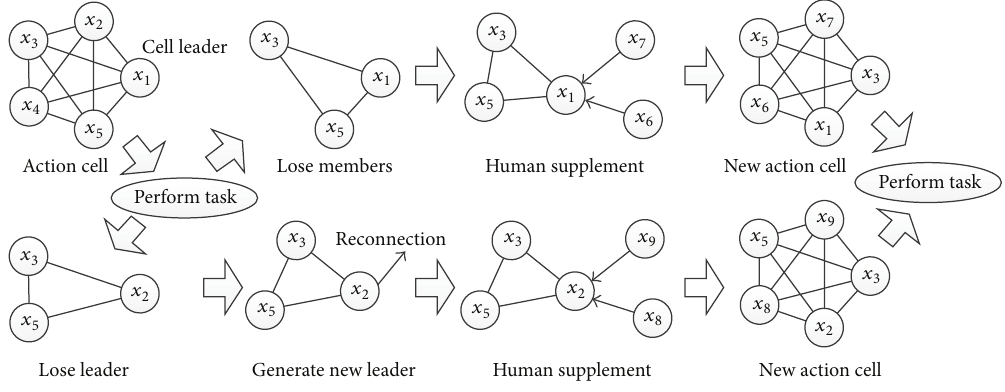
Figure 5: The recovery process of action cell.